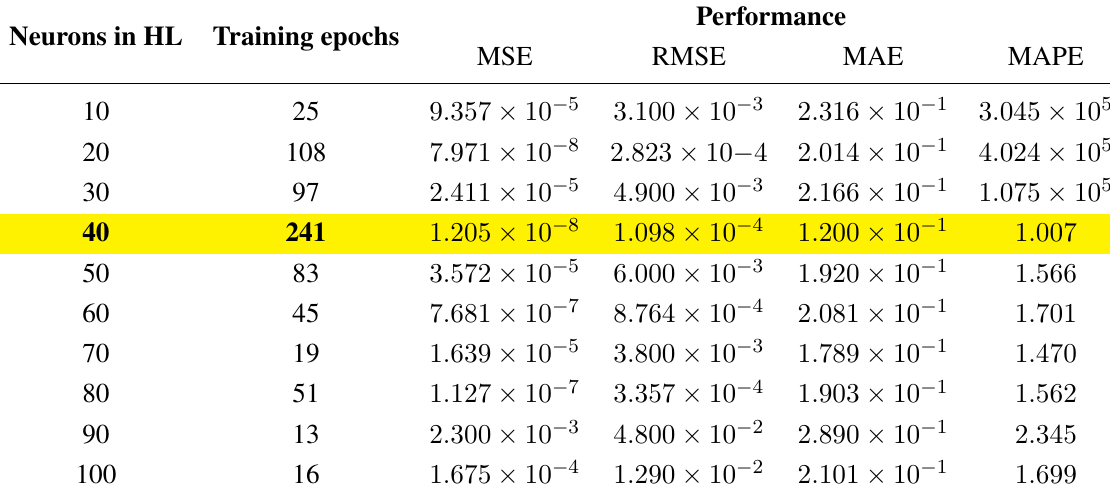
Table 4. Performance in the winter